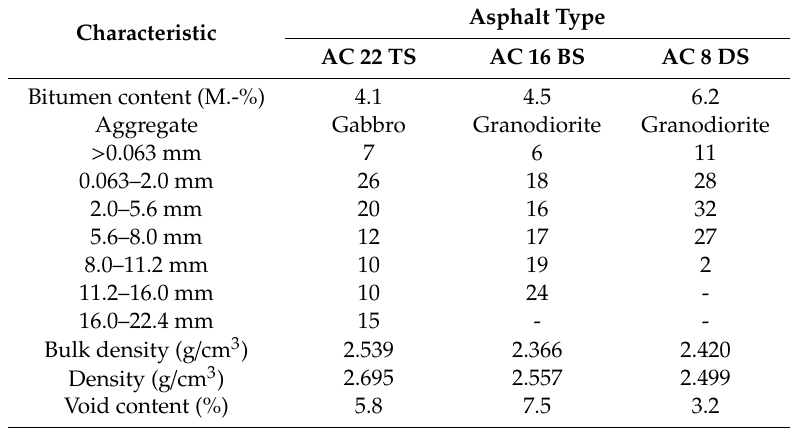
Table 1. Gradations of the used asphalt types.